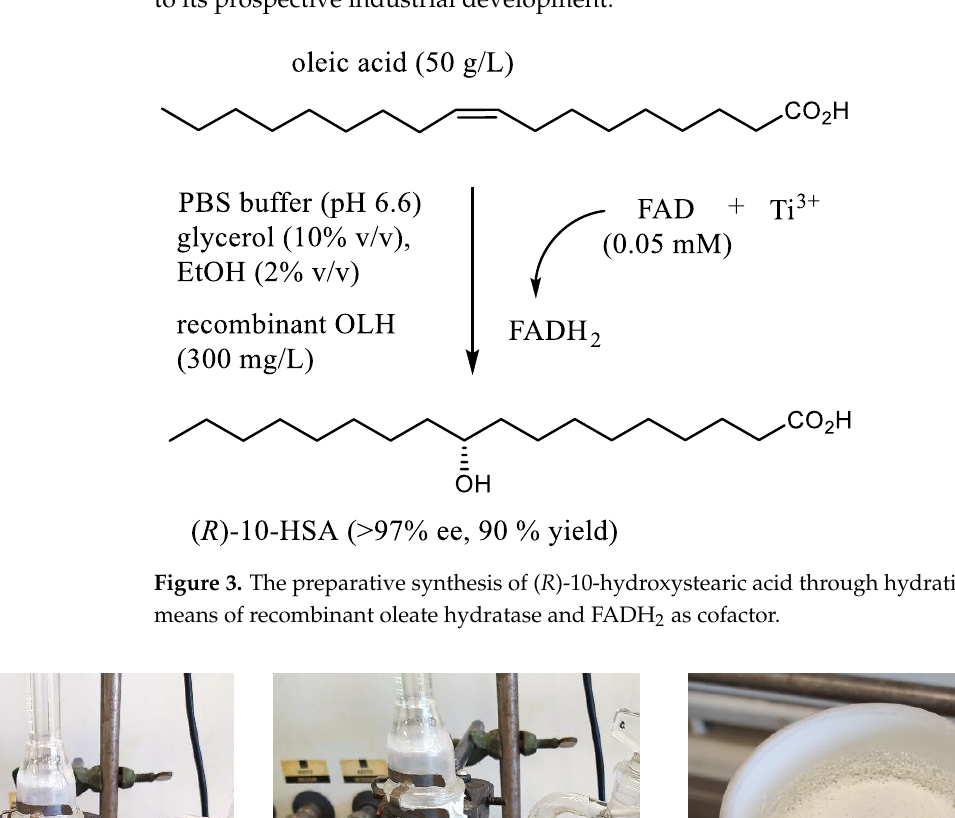
Figure 3. The preparative synthesis of ( R )-10-hydroxystearic acid through hydration of oleic acid by means of recombinant oleate hydratase and FADH 2 as cofactor.